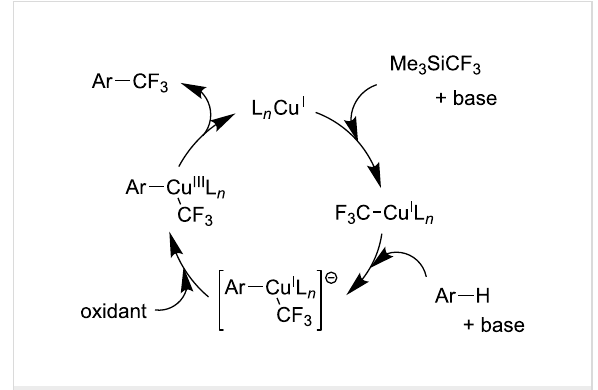
Figure 10: F.-L. Qing et al.’s proposed mechanism for the copper- catalyzed trifluoromethylation of (hetero)arenes with the Ruppert–Prakash reagent